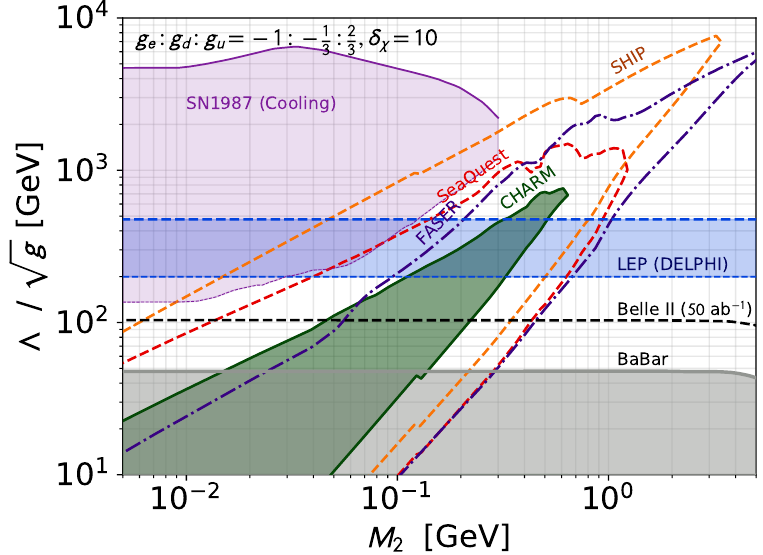
p g in the case of